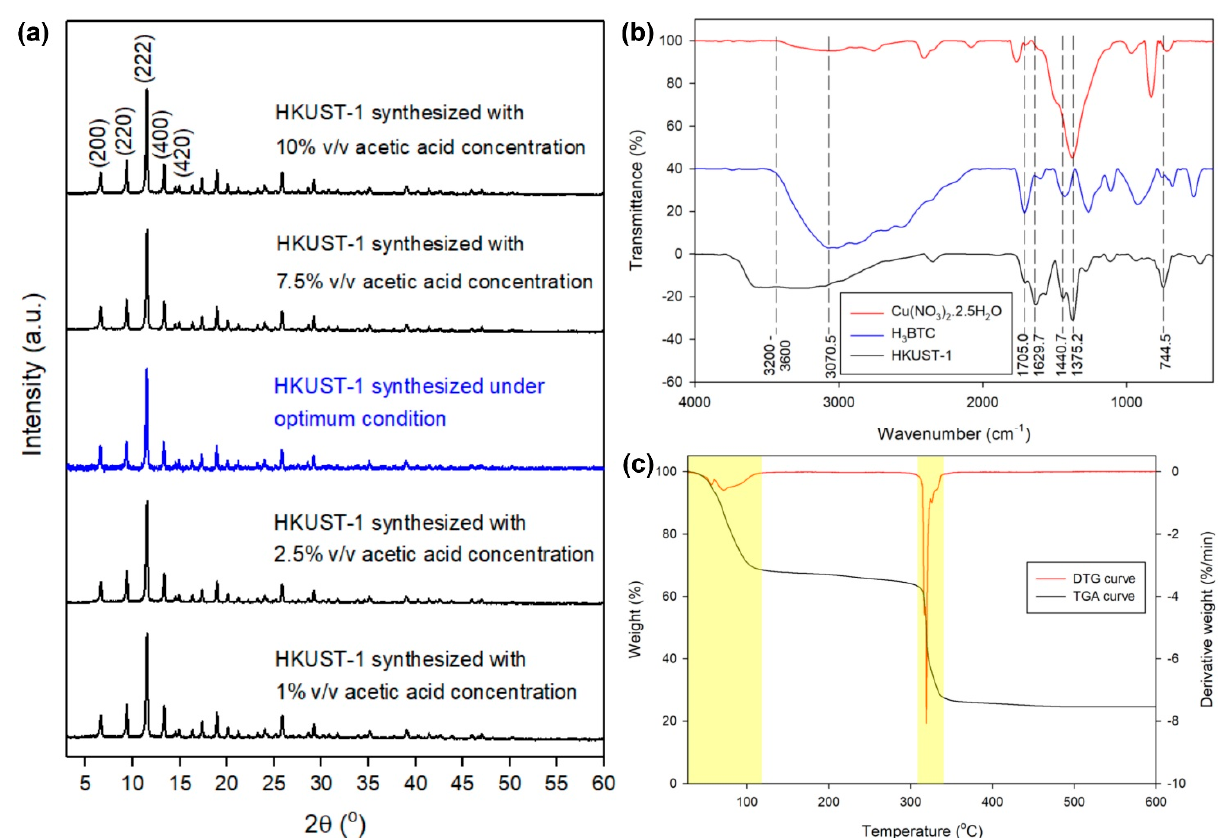
Figure 7. ( a ) XRD spectra of HKUST-1 synthesized under optimum condition and with various acetic acid concentrations, ( b ) FTIR spectra of HKUST-1 synthesized under optimum condition and its precursors, and ( c ) TGA-DTG curves of HKUST-1 synthesized under optimum condition. Table 4. Crystal information of HKUST-1 synthesized under optimum condition and with various acetic acid concentra- tions.